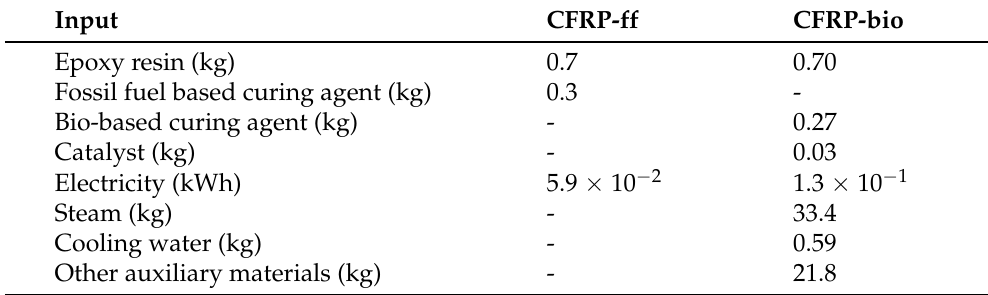
Table 4. Mixing of the epoxy resin and the dynamic curing agent according to the two scenarios. Data are referred to 1 kg of uncured vitrimer. Epoxy resin/dynamic curing agent ratio from de Luzuriaga et al. [3].